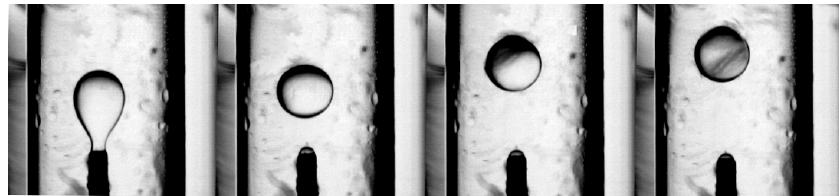
Figure 2. Sequence of photos illustrating single droplet detachment from the steel needle tip under the shear flow of generated water impulse.